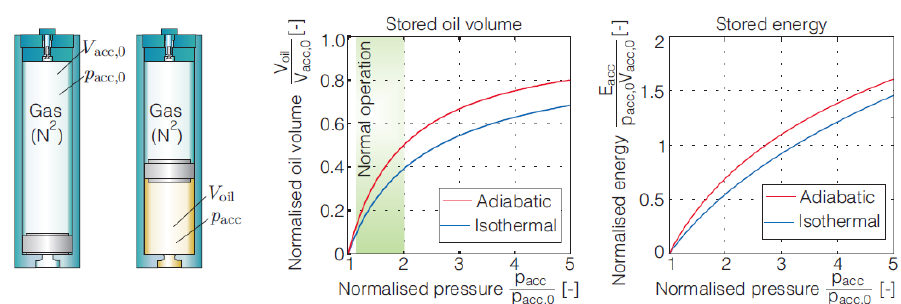
Figure 12. Gas-charged accumulators and their behaviour [13]. Figure supplied courtesy of Rico H.